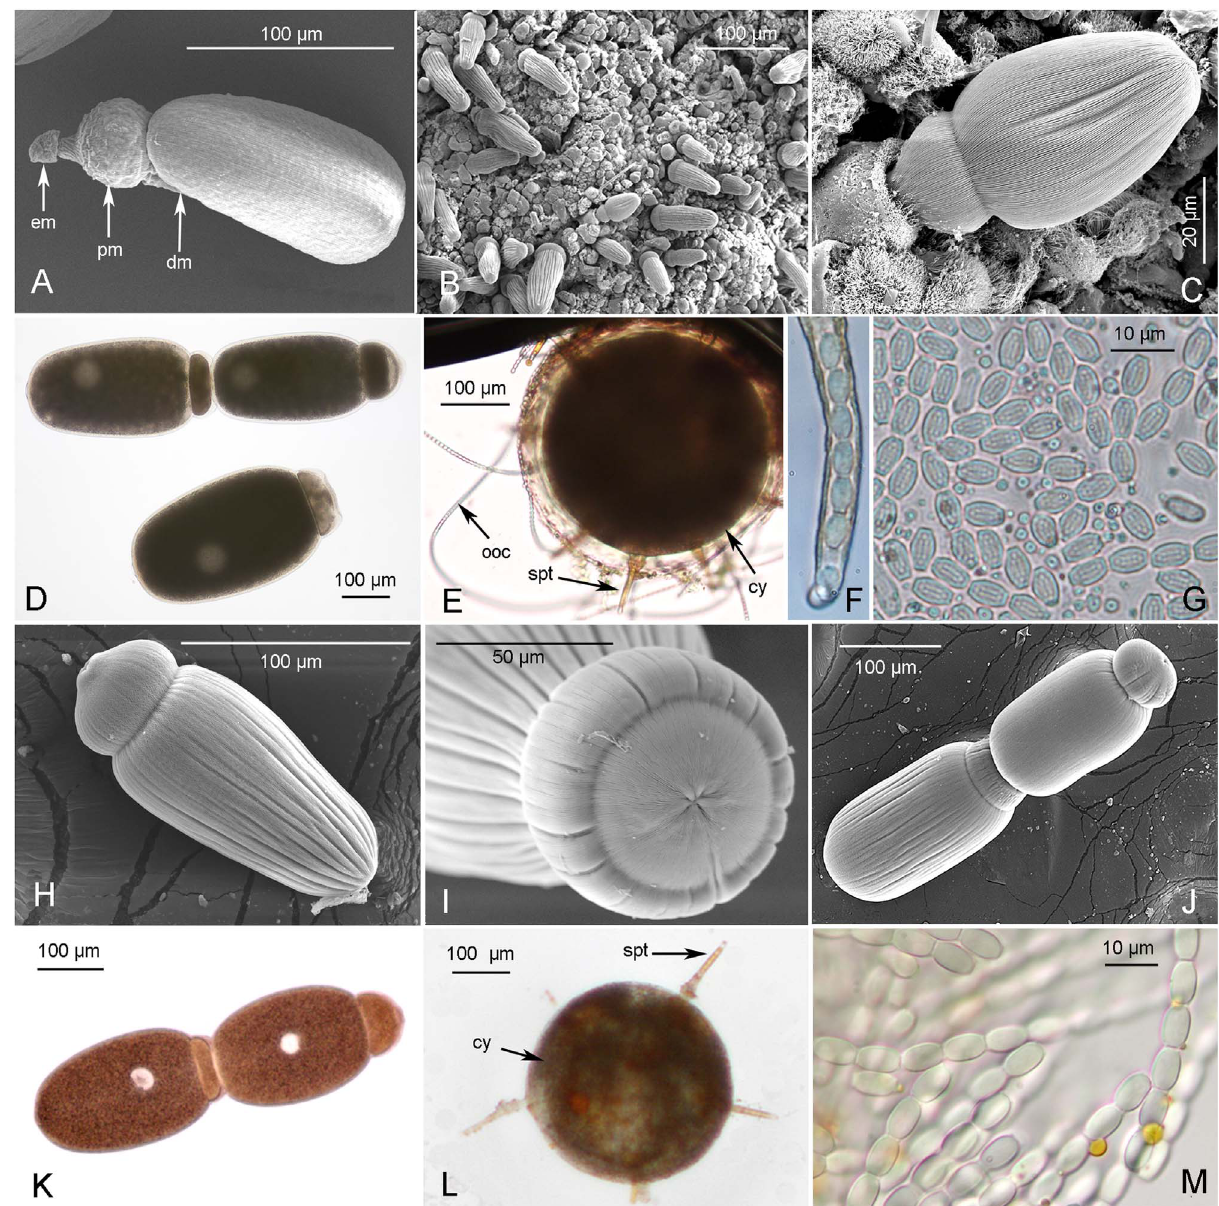
Figure 1. Scanning Electron Microscopy (A – C, H – J) and photonic imaging (D – G, K – M) of gregarines infecting S. gregaria (A – G) and L. migratoria (H – M). S. gregaria gregarines: A, young trophozoite (epimerite (em) protomerite (pm) and deutomerite (dm)), (South Africa); B, intestinal tract infected by numerous gregarines (Morocco); C, gregarine encased in an intestinal host cell, enlargement of B (Morocco); D. Solitary gamont and syzygy (Belgium); E. Gametocyst form (cy) with developed sporoducts (spt) releasing oocyst chains (ooc); F, zoom on sporoduct extremity showing enclosed oocysts; G. released oocysts. L. migratoria gregarines: H, solitary gamont detached from intestinal host cell; I. zoom on gamont protomerite; J – K, gamonts associated in syzygies; L, Gametocyst form (cy) with developed sporoducts (spt); M. released oocysts. Scales are given for each fi